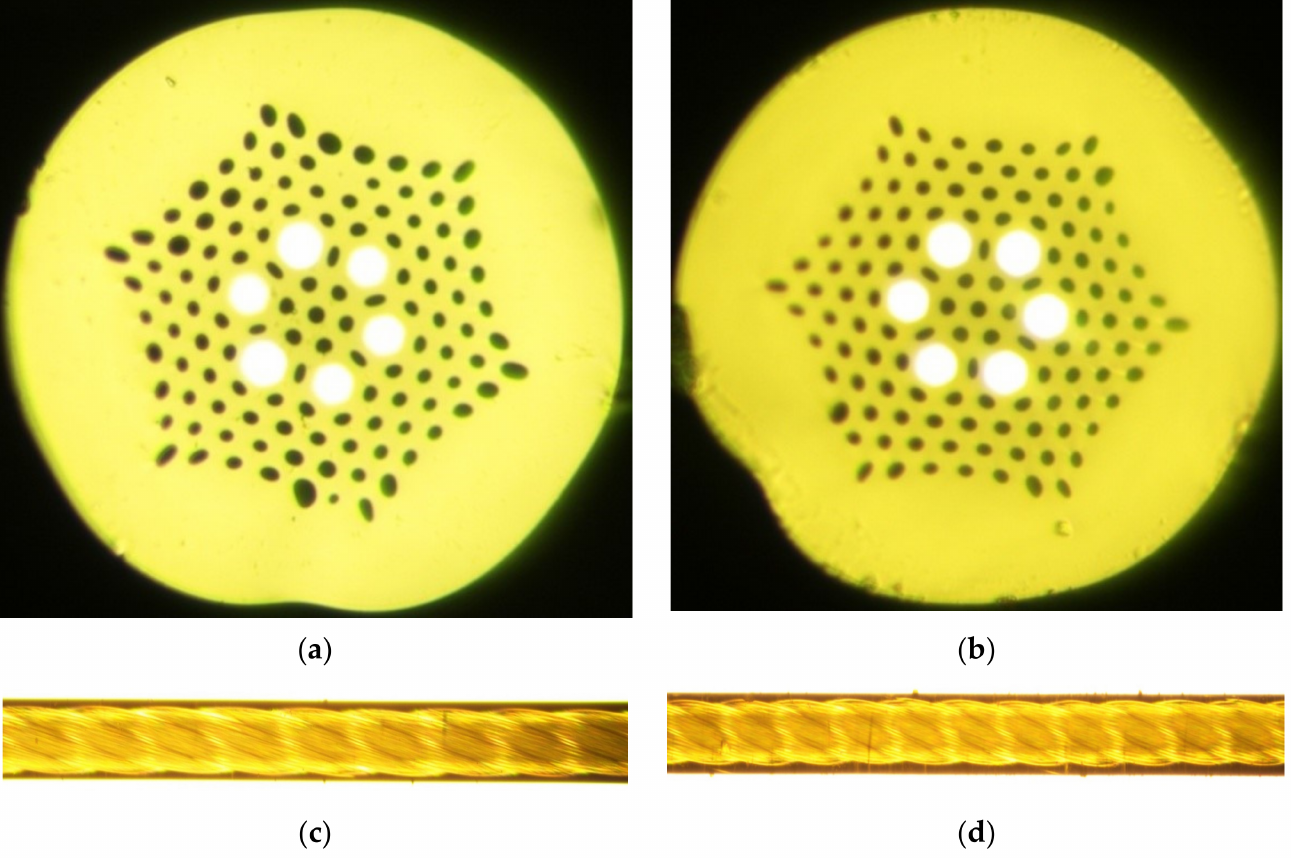
Figure 11. Strongly twisted six-core-MOFs with graded-index core supporting elements: ( a ) cross- section view of the fabricated MOF with twisting 400 rpm; ( b ) cross-section view of the fabricated MOF with twisting 500 rpm; ( c ) longitudinal view of the fabricated MOF with twisting 400 rpm; ( d ) longitudinal view of the fabricated MOF with twisting 500